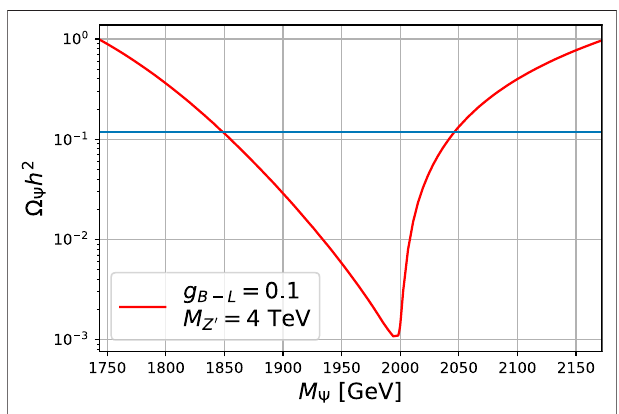
FIGURE 5 | Dirac fermionic Dark matter relic density as a function of its mass for U (1) B − L with copuling g B − L = g X = 0.1, M Z ’ = 4 TeV, m S = 5